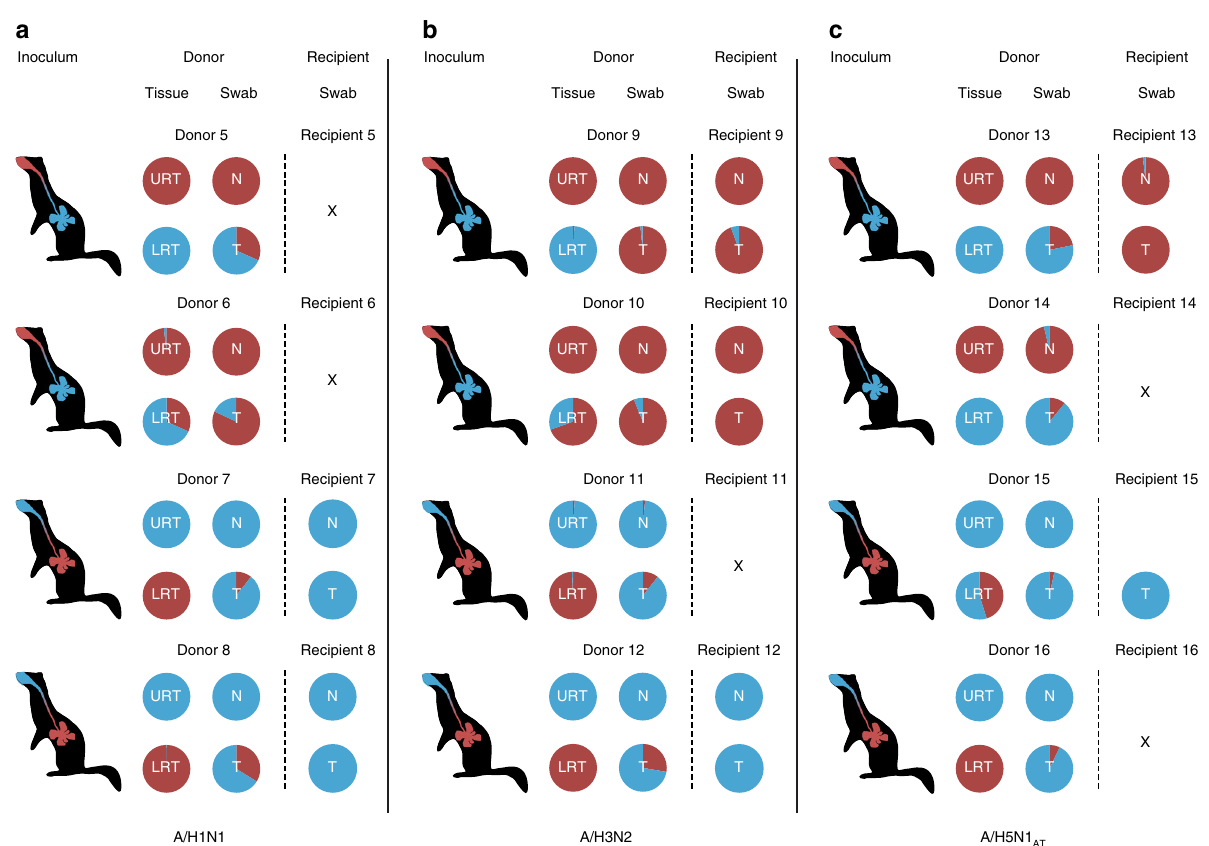
Fig. 2 A/H1N1, A/H3N2 and A/H5N1 AT viruses were transmitted from the upper respiratory tract of ferrets. Ferrets were inoculated with 10 5 TCID 50 of untagged (shown in red) and tagged (shown in blue) virus pairs of A/H1N1 virus ( a Donors 5 – 8), A/H3N2 virus ( b Donors 9 – 12) or A/H5N1 AT virus ( c Donors 13 – 16). Untagged and tagged viruses were inoculated either intranasally or intratracheally as indicated by the color coding in the schematic ferret representations. Untagged and tagged virus proportions at the day of virus transmission are represented by the pie charts for both donor and recipient ferrets. URT: upper respiratory tract, i.e., nasal turbinates, LRT: lower respiratory tract, i.e., combined data from two parts of the trachea and the lungs, N: nose swabs, T: throat swabs. X means that no transmission was observed. Transmission was de fi ned by the detection of two consecutive swabs with a RT- qPCR threshold (CT-value) of 35. Source data are provided as a Source Data fi